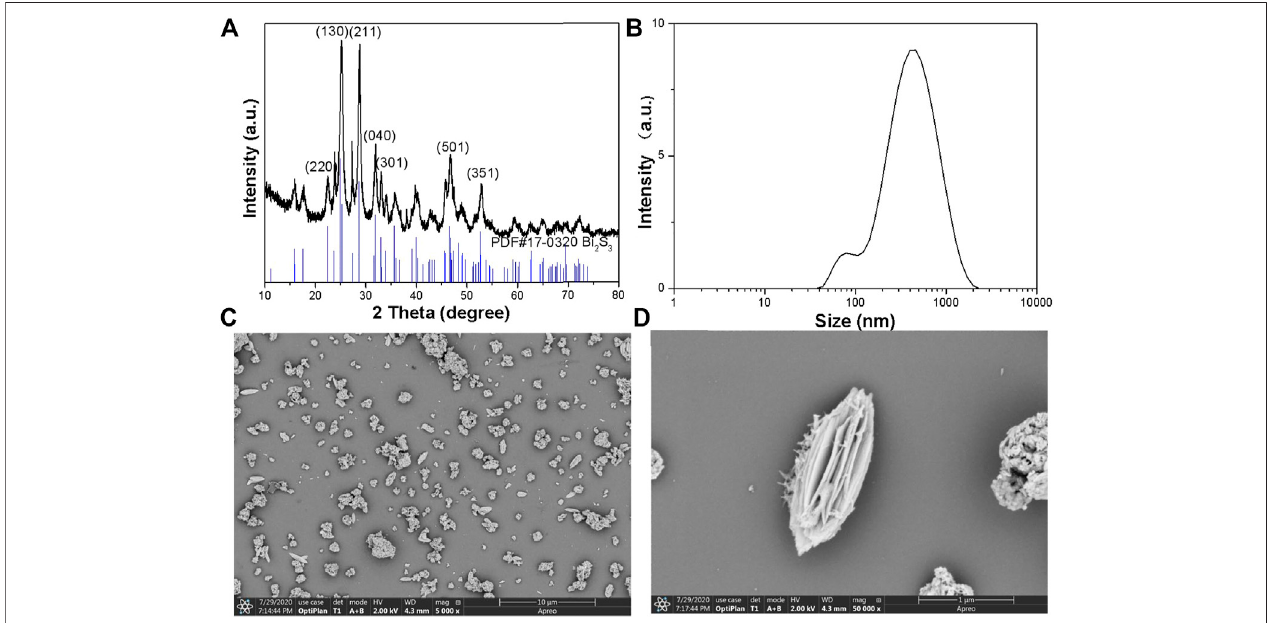
FIGURE 1 | (A) Powder XRD patterns of the as-prepared nanocrystals and the standard Bi 2 S 3 powders. (B) DLS of the Bi 2 S 3 NPs. (C) The SEM images of the Bi